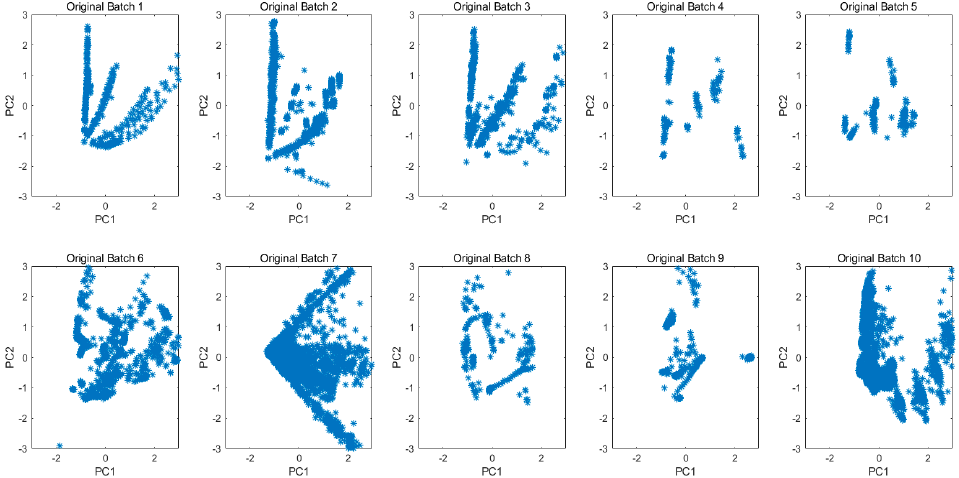
Figure 6. Principal component space of 10 batches for all original data.